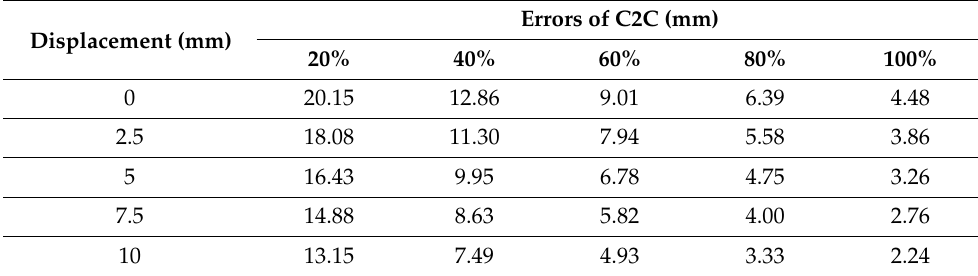
Figure 14. Displacement estimation in Sheet pile, ( a ) Displacement calculated by C2C, ( b ) Displacement calculated by C2M, ( c ) Displacement calculated by M3C2. Table 3. Displacement errors of C2C, C2M, and M3C2 in sheet